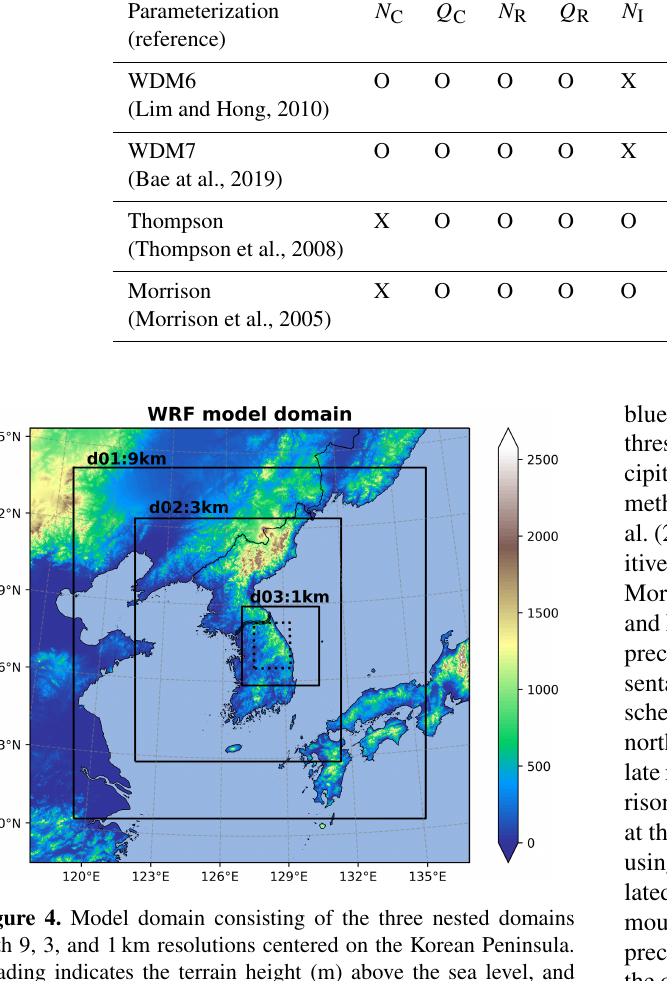
Table 3. Four bulk-type cloud microphysics parameterizations and their prognostic variables. The existence of prognostic variables in each parameterization is denoted with “O” (existence) or “X” (nonexistence). N X and Q X represent the number concentration and mixing ratio of a hydrometeor, X . The subscripted C, R, I, S, G, and H indicate cloud water, rain, cloud ice crystal, snow, graupel, and hail, respectively. Parameterization N C Q C